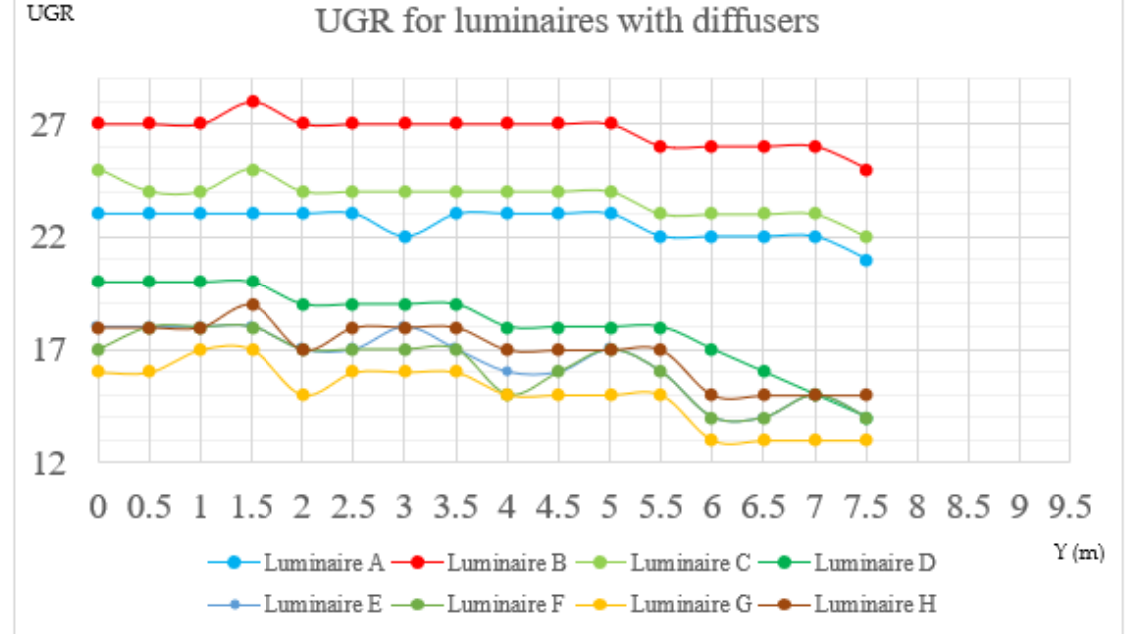
Figure 7. Eight LED luminaires’ UGR curves (luminaires described in Figure 6a–h) along the room’s midline when observer’s viewing direction is parallel to the luminaires’ axis.